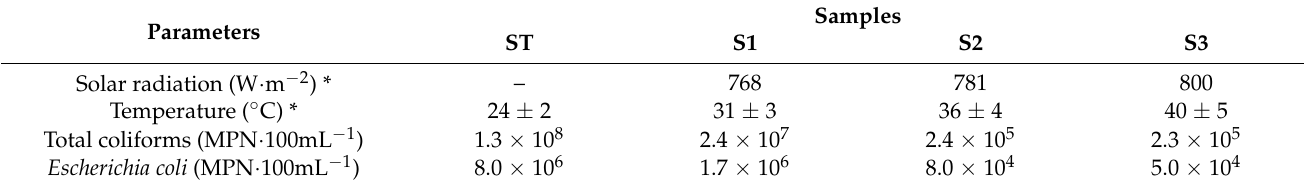
Table 2. Results for solar radiation and most probable number (MPN) of total coliforms and Escherichia coli . Parameters